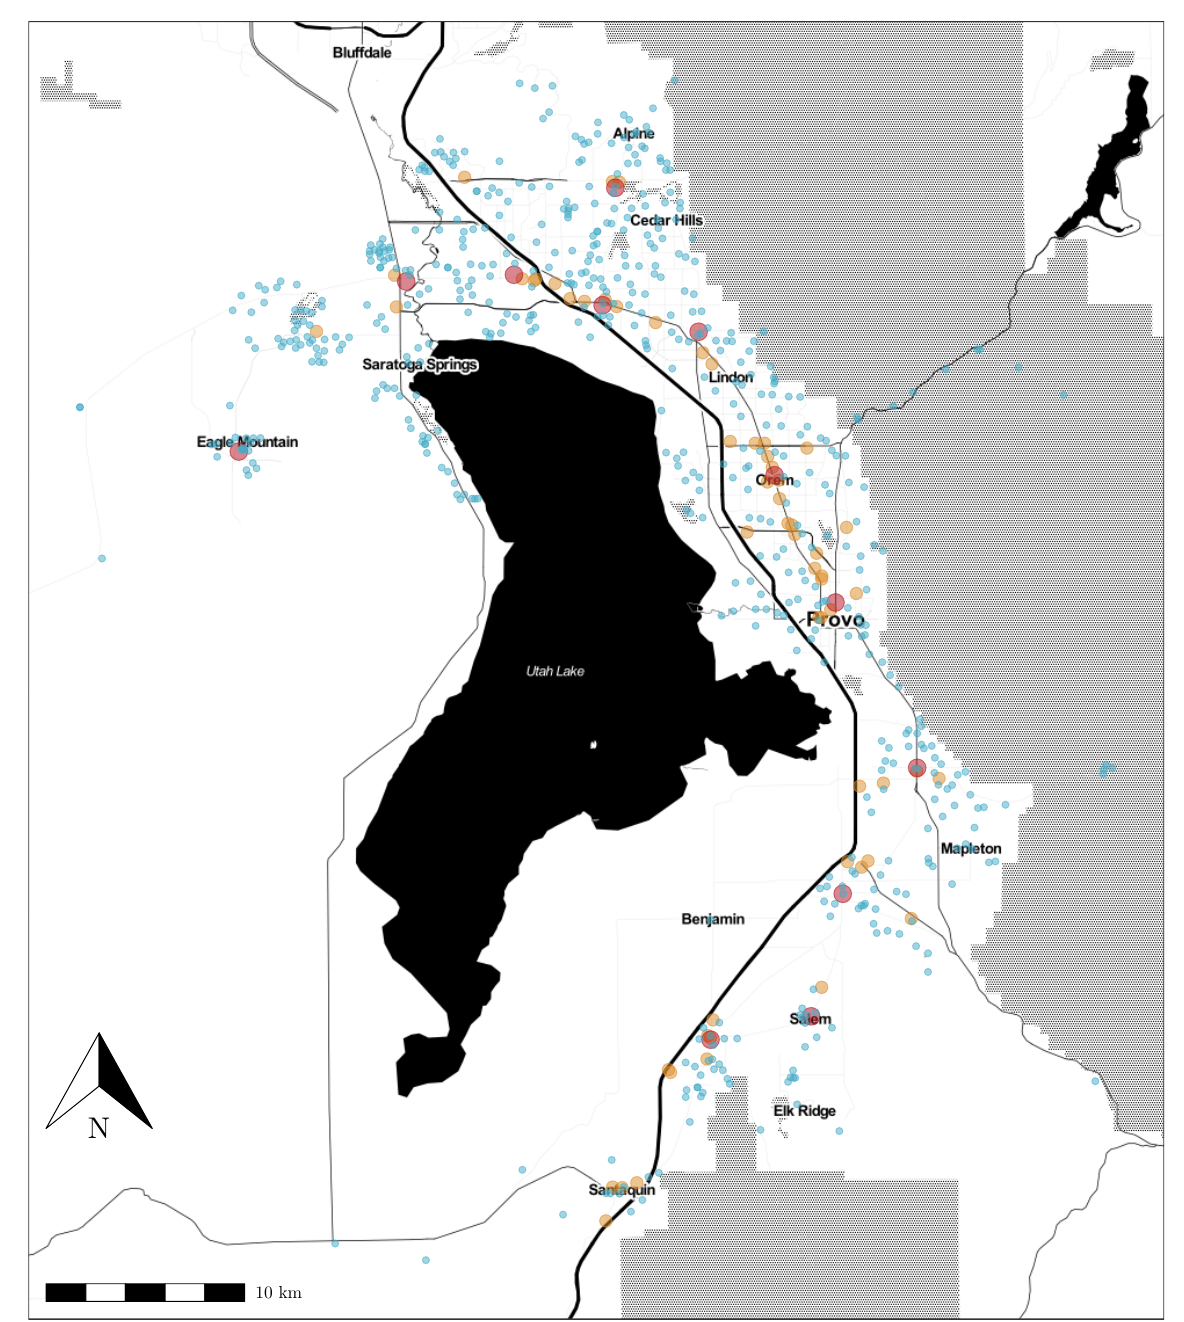
Figure 2. Location of community resources in Utah